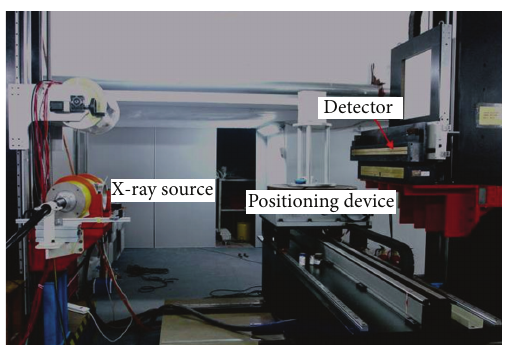
Figure 2: 450 kV X-ray computed tomography machine